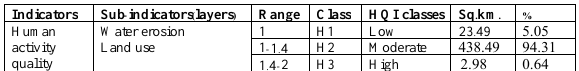
Table 8. Quantitative scores and qualitative classes of Human activity quality indicators.